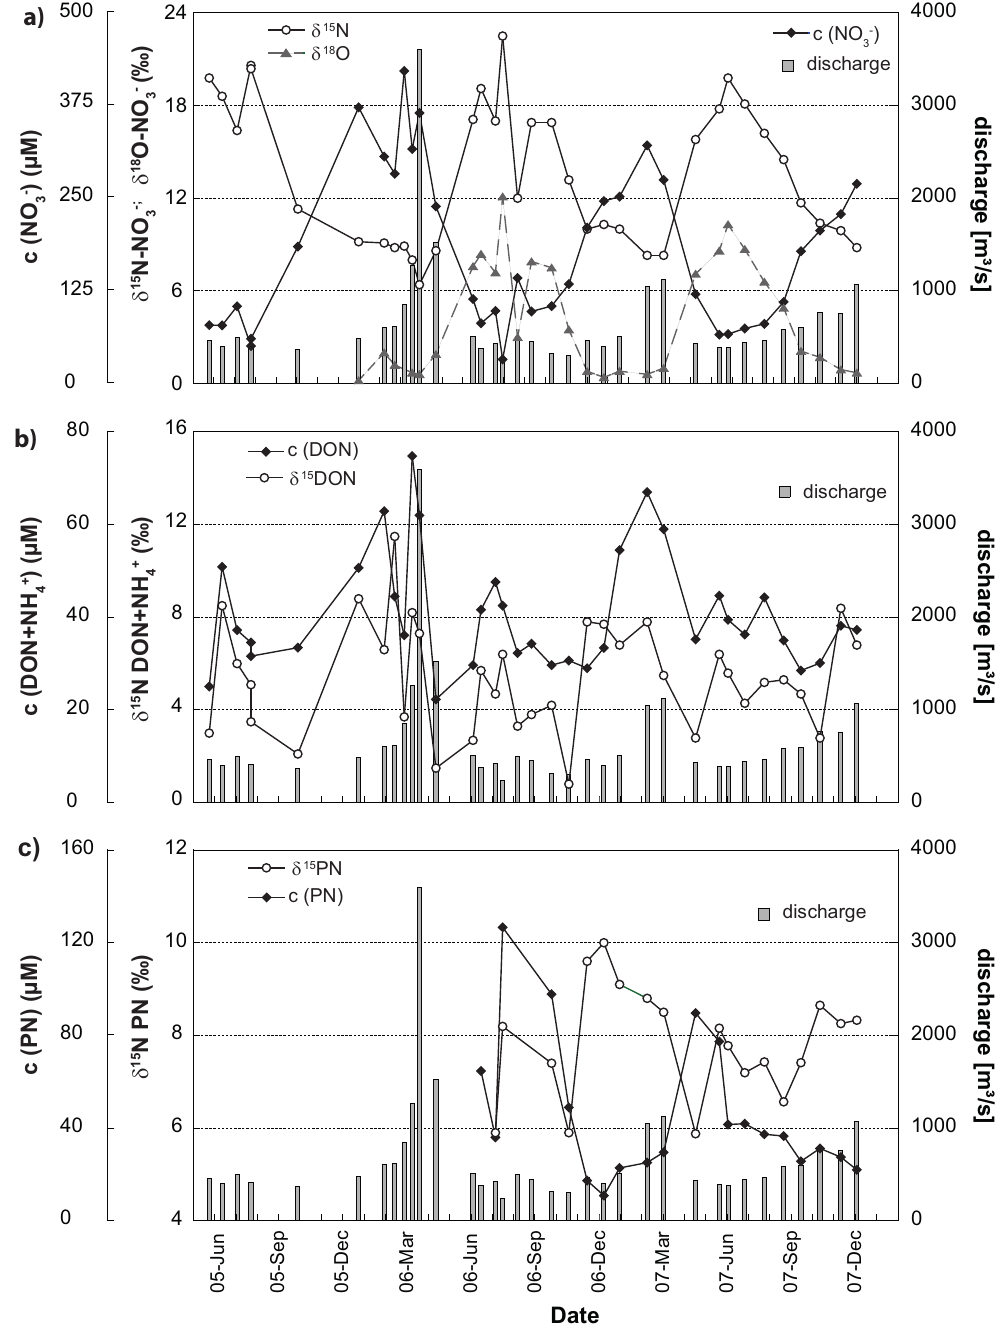
Fig. 2. Concentration and isotopic values in the Elbe River at the weir of Geesthacht, June 2005–December 2007, bars represent the river discharge. Note the different scales of the y-axes. (a) Nitrate concentration, δ 15 N − NO − 2006 have been published in Johannsen et al. (2008). (b) combined DON+NH + and δ 15